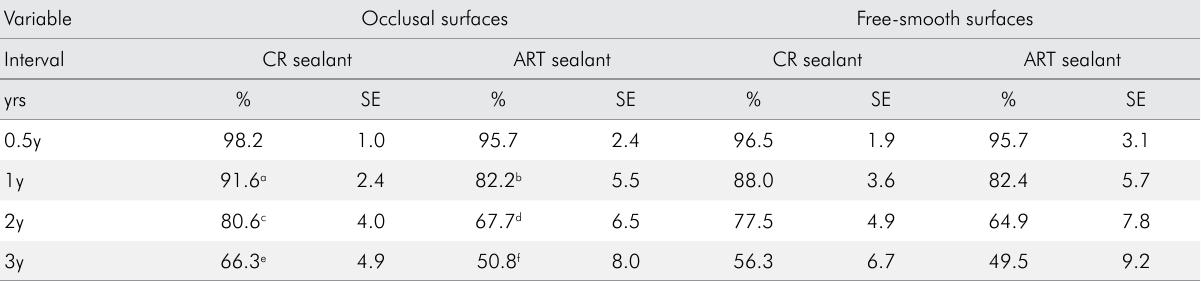
Table 3. Cumulative survival rates (%) and standard errors (SE) of fully and partially retained sealants calculated according to the traditional criterion in occlusal and free-smooth surfaces over a period of 3